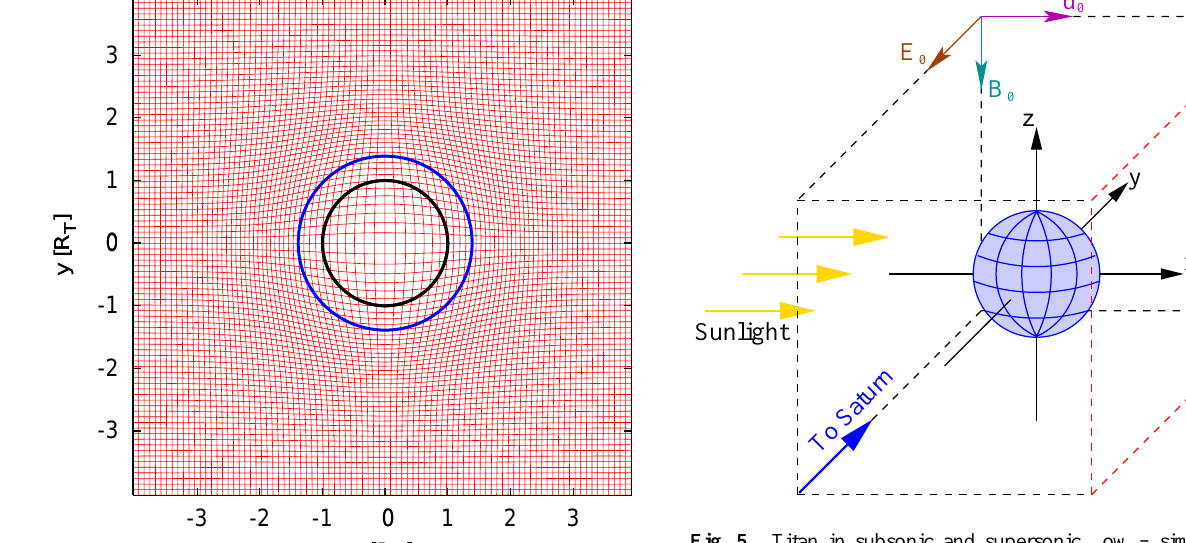
Fig. 5. Titan in subsonic and supersonic flow – simulation ge- ometry. The interaction of Titan’s ionosphere with the super- Alfv´enic, yet subsonic and submagnetosonic Saturnian magneto- spheric plasma flow has been studied by using a cubic simulation domain with a length of 15 R T in each direction. The center of the obstacle coincides with the origin of the Cartesian coordinate system shown in the sketch. The undisturbed plasma flow velocity points in ( + x) direction; the homogeneous background magnetic field is orientated in ( − z) direction. Thus, the convective electric field is antiparallel to the ( + y) axis and points away from Sat- urn. The dayside of the obstacle is located in the (x< 0 ) half space, i.e. the obstacle’s terminator plane coincides with the (y,z) plane. The boundary that is located in the wake region is denoted by red lines. The simulation geometry for Titan being exposed to a super- Alfv´enic, supersonic and supermagnetosonic plasma flow is exactly the same as the one shown in the sketch. Only the numerical values of the upstream plasma betas differ from the first